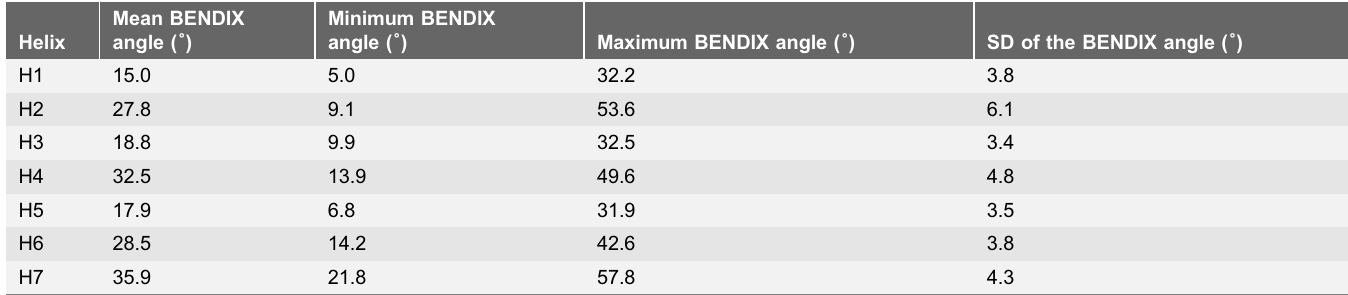
Table 3. Minimum, maximum, mean, and standard deviation (SD) values of the maximum helix angle value observed using the BENDIX representation for to the different helices of the m OR structure from the 0.5 m s all-atom MD